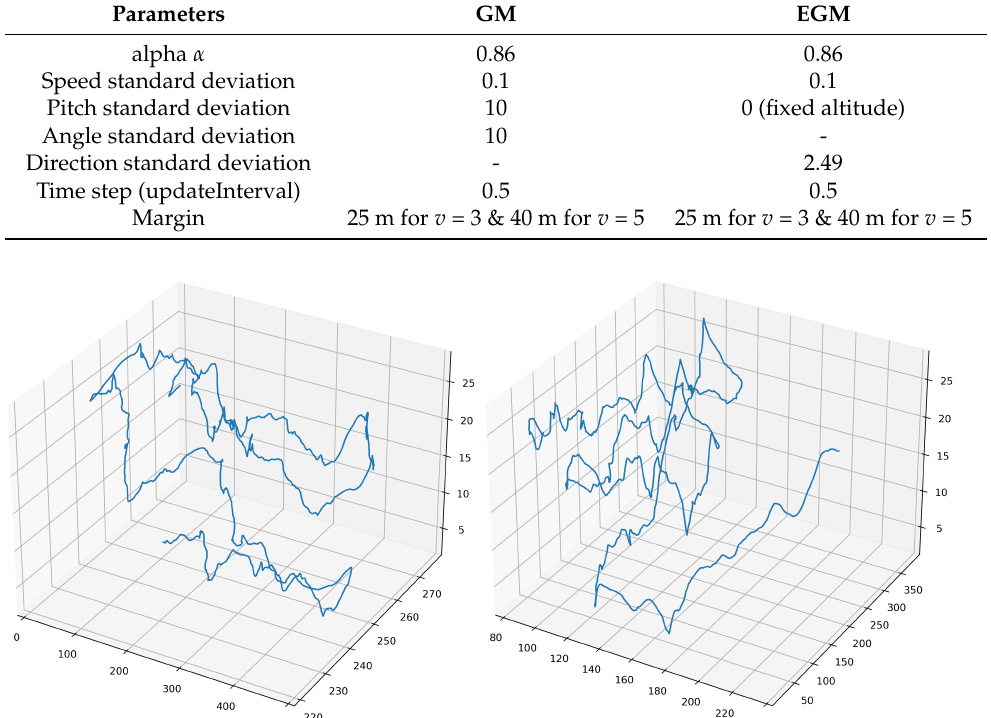
Table 2. Simulation parameters for GM and EGM.